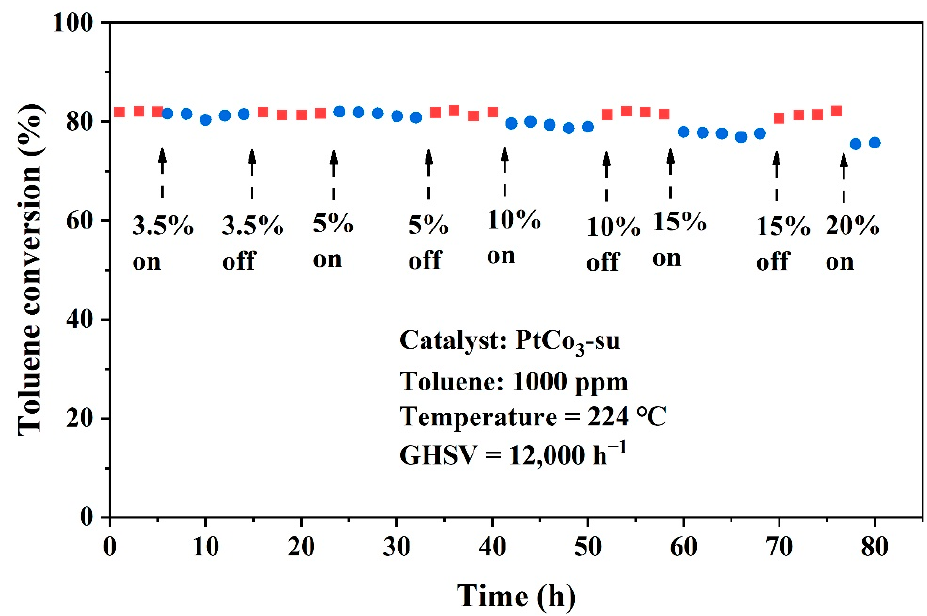
Figure 4. Reaction stability with time for toluene oxidation over PtCo 3 -su catalyst with 3.5 vol% to 20 vol% water vapor contents.